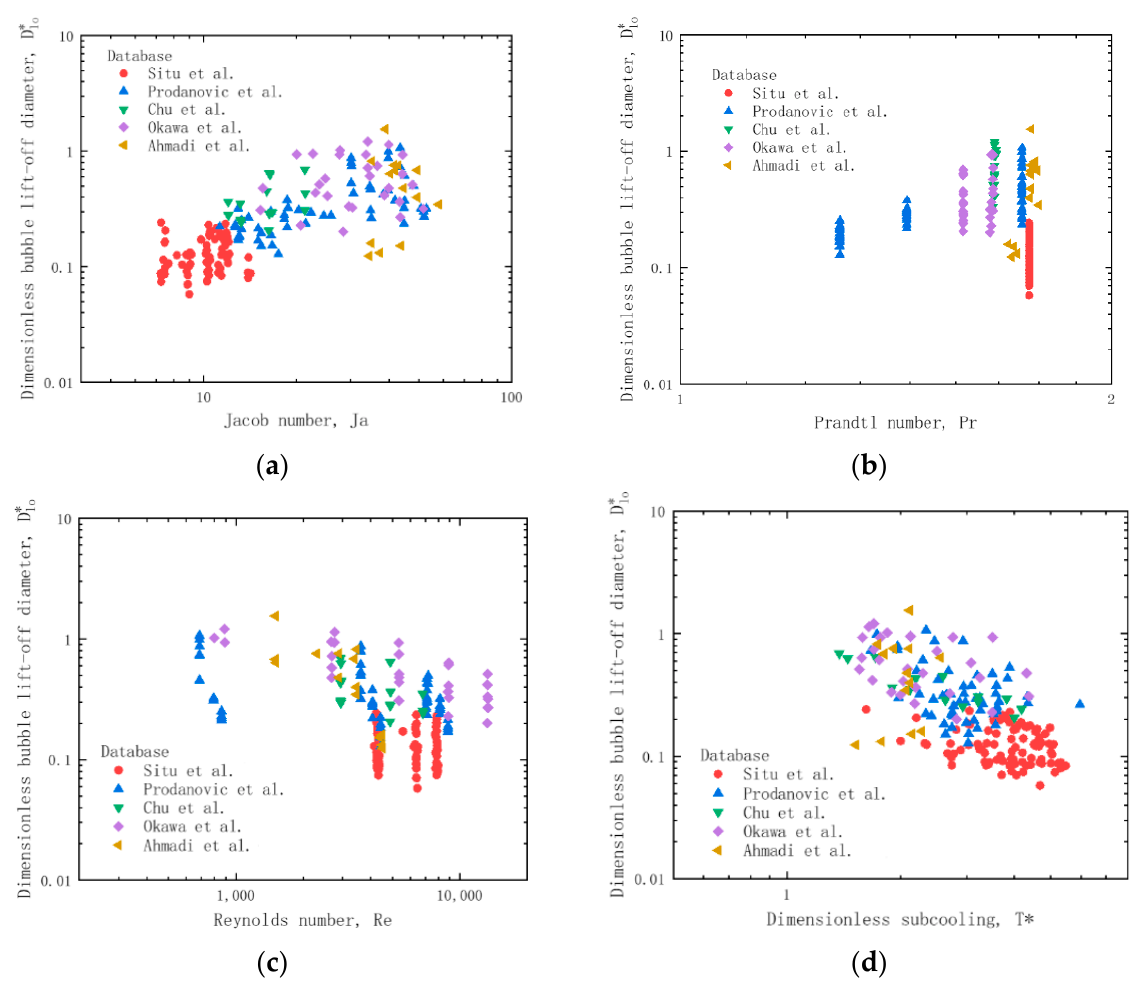
Figure 3. Non-dimensional lift-off diameters changing with dimensionless parameters. ( a ) The effect of the Jacob number; ( b ) The effect of the Prandtl number; ( c ) The effect of the Reynolds number; ( d ) The effect of dimensionless subcooling